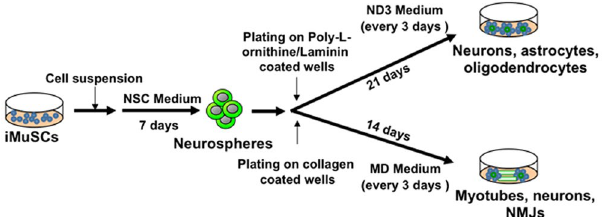
Figure 1. In vitro differentiation protocol. Undifferentiated iMuSCs were cultured in Neural Stem Cell (NSC) Medium in suspension for 7 days to induce neurosphere formation. For myotube differentiation, neurospheres were plated on collagen-coated wells in Muscle Differentiation (MD) Medium. For neural differentiation, neurospheres were plated on laminin/poly-L-ornithine coated wells and cultured for 21 days in Neural Differentiation (ND3)